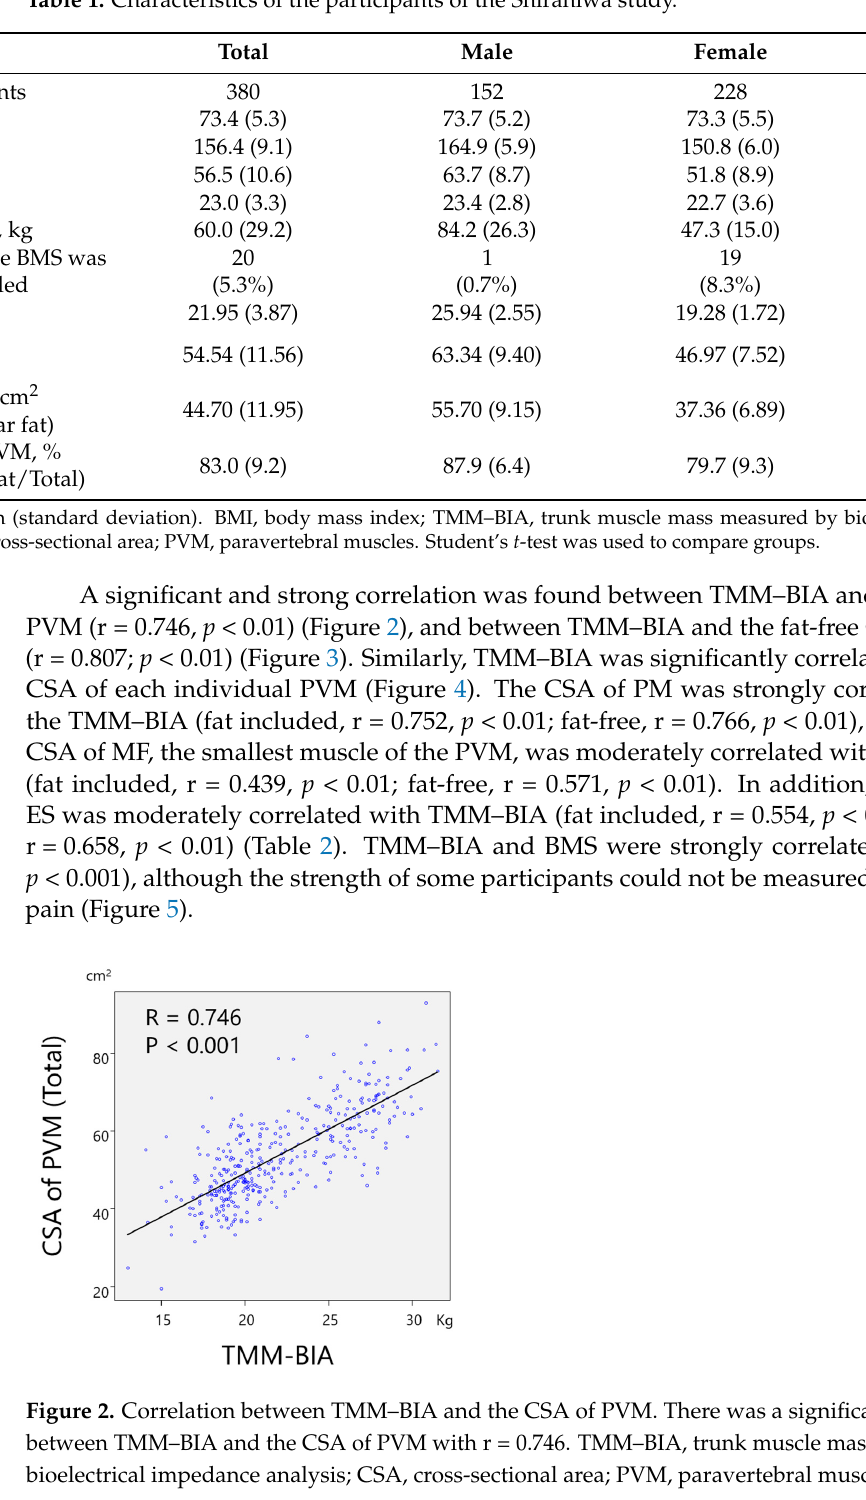
Figure 3. Correlation between TMM–BIA and the CSA of PVM without intramuscular fat. There was a significant correlation between TMM–BIA and the CSA of fat-free PVM with r = 0.807. TMM–BIA, trunk muscle mass measured by bioelectrical impedance analysis; CSA, cross-sectional area; PVM, paravertebral muscles.